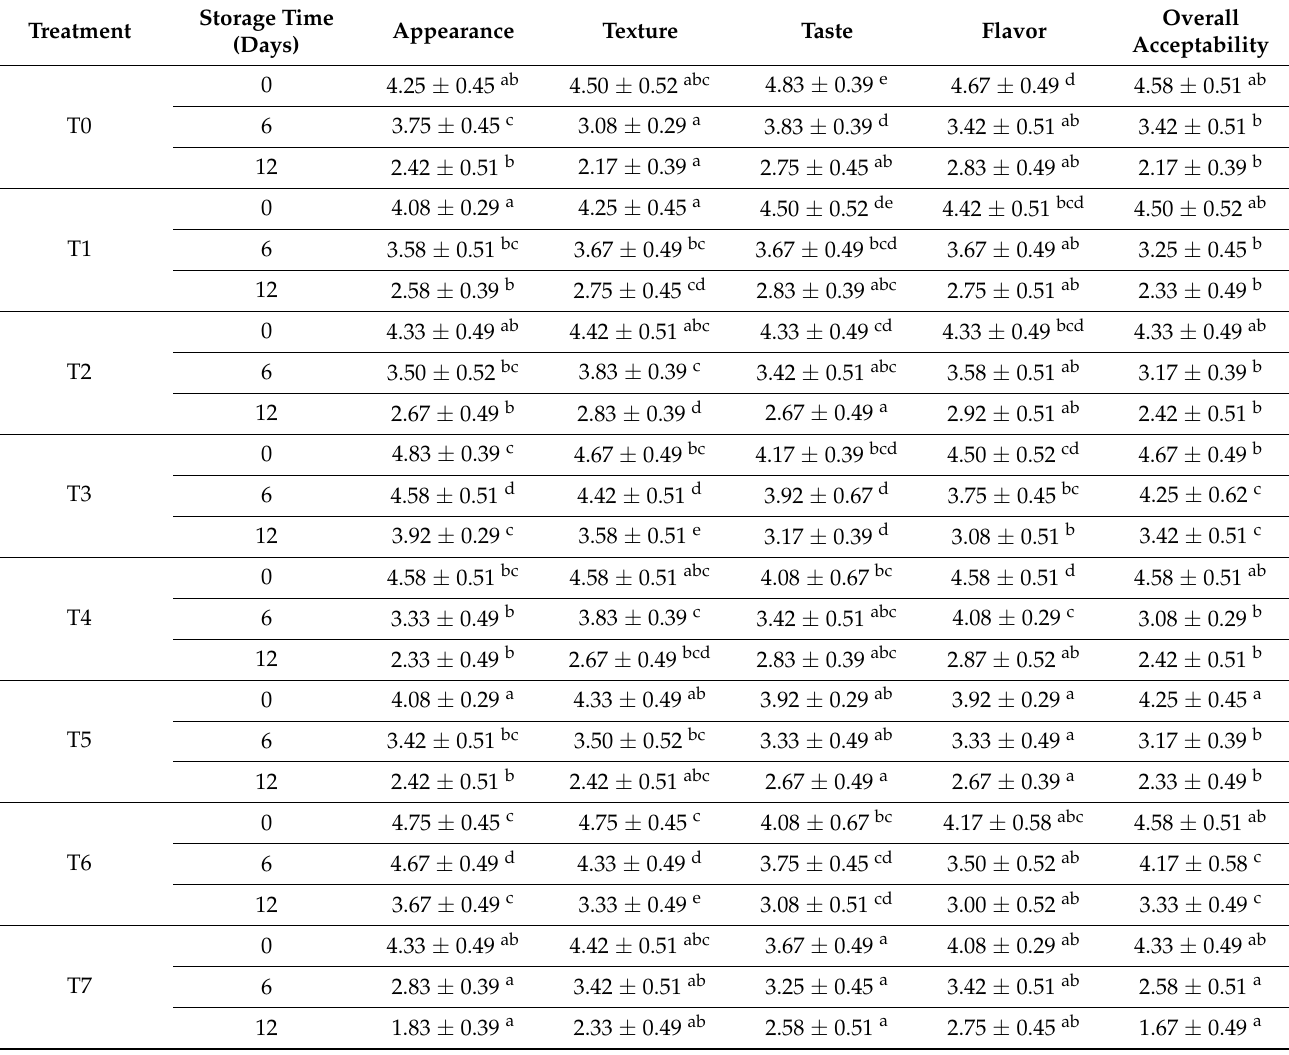
Table 2. Scores for sensory analysis of control and treated fresh-cut pears at 0, 6 and 12 days of storage at 8 ◦ C